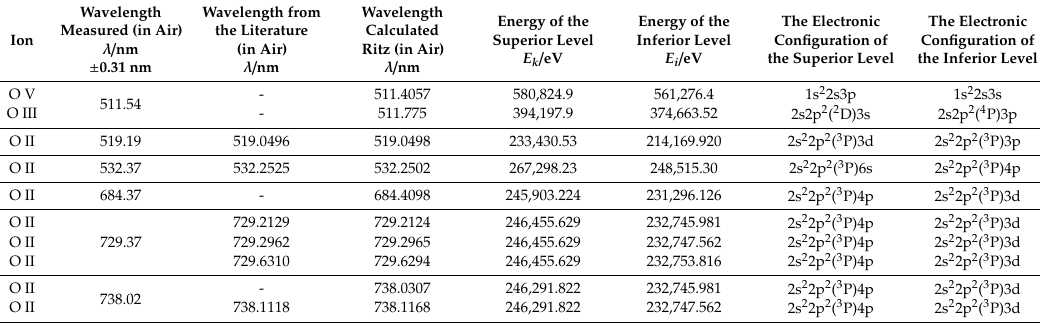
Table 8. Atomic oxygen fluorescence (BTA in acetone solution with c =